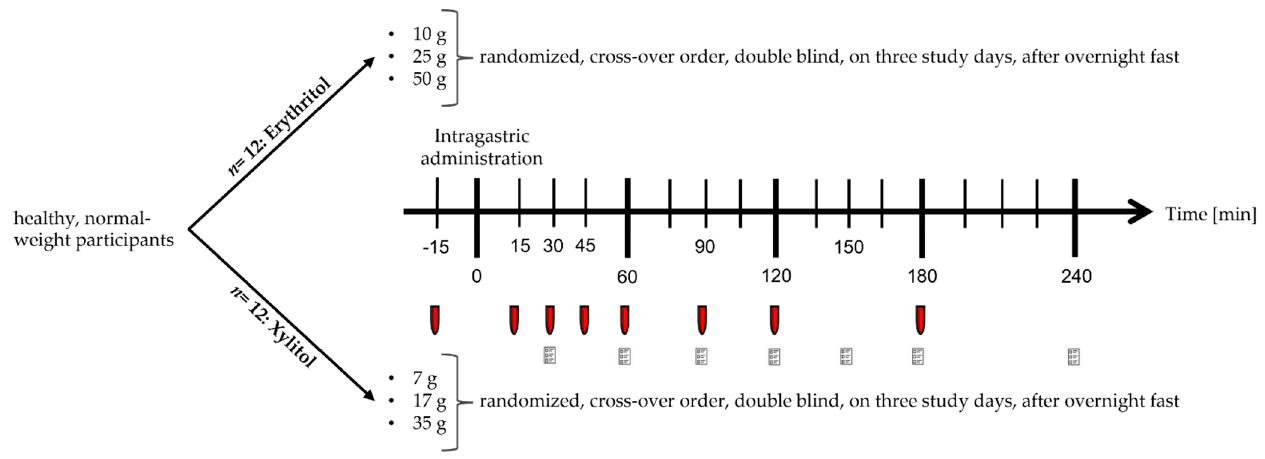
Figure 6. Diagram of the experimental procedure. The red tubes stand for blood sampling, the paper forms stand for gastrointestinal symptoms